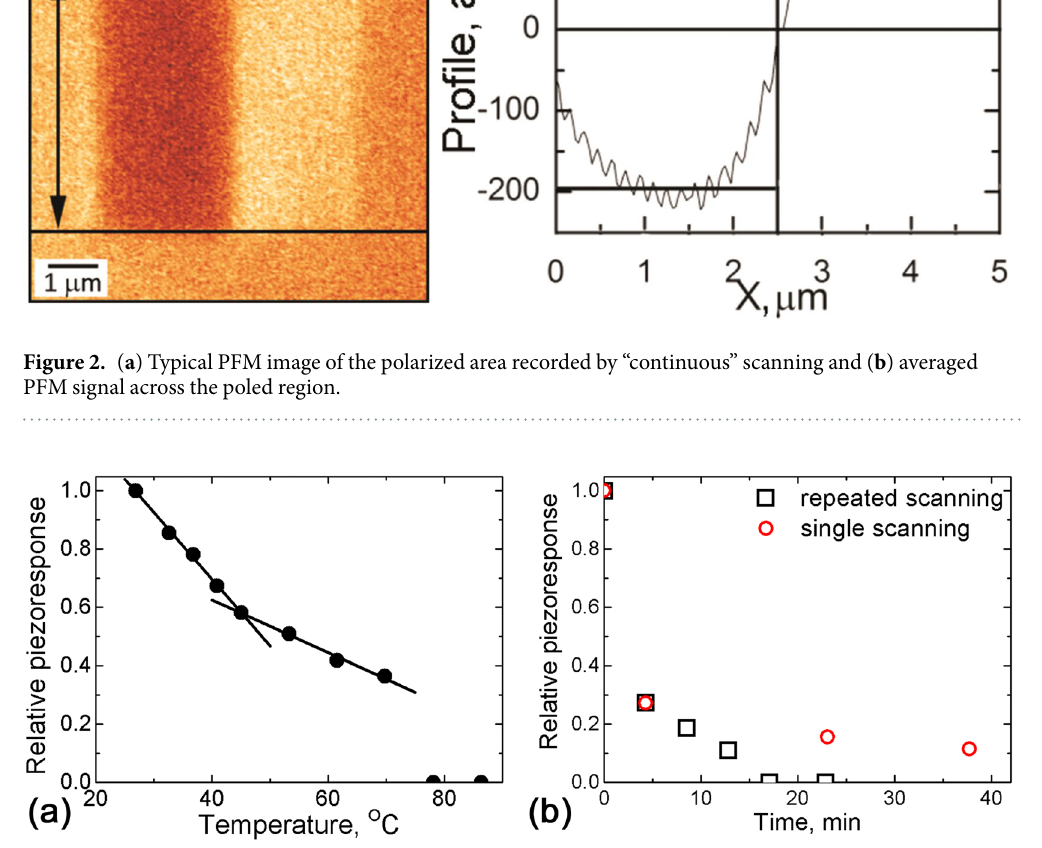
Figure 3. ( a ) Temperature dependence of the relative piezoresponse of the polarized areas in SBN75. Experimental points are fitted by linear dependences. ( b ) Time dependence of the relative PFM contrast of the polarized areas in SBN75 for single and repeated scanning at room temperature. The poling voltage U dc = 40